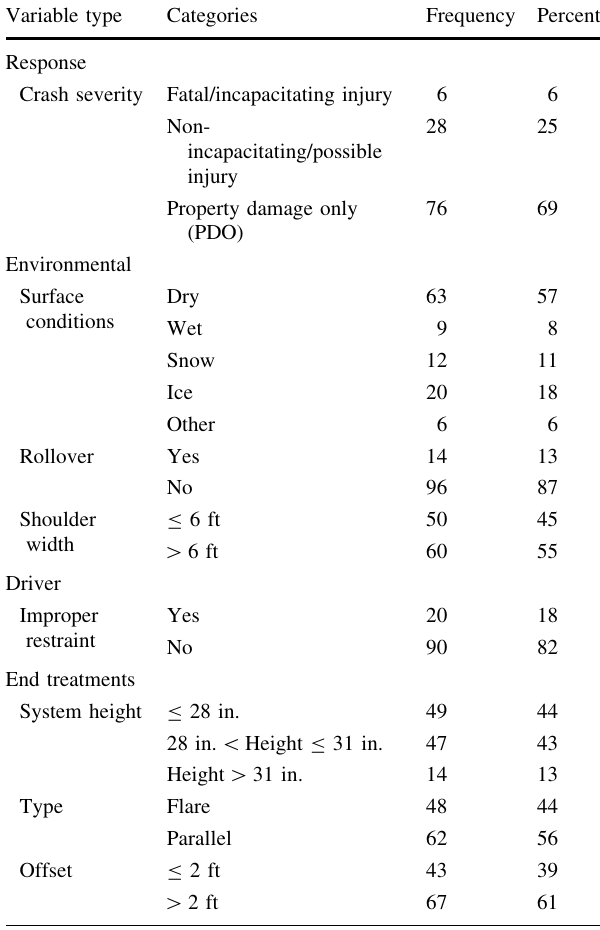
Table 5 Statistics of dependent and significant independent variables for crashes involving end